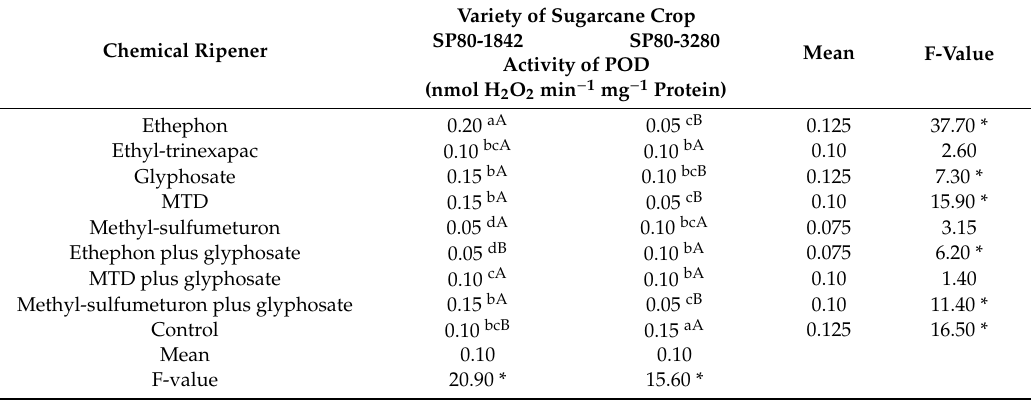
Table 6. Interaction e ff ect of chemical ripening agents and varieties of sugarcane on the activity of